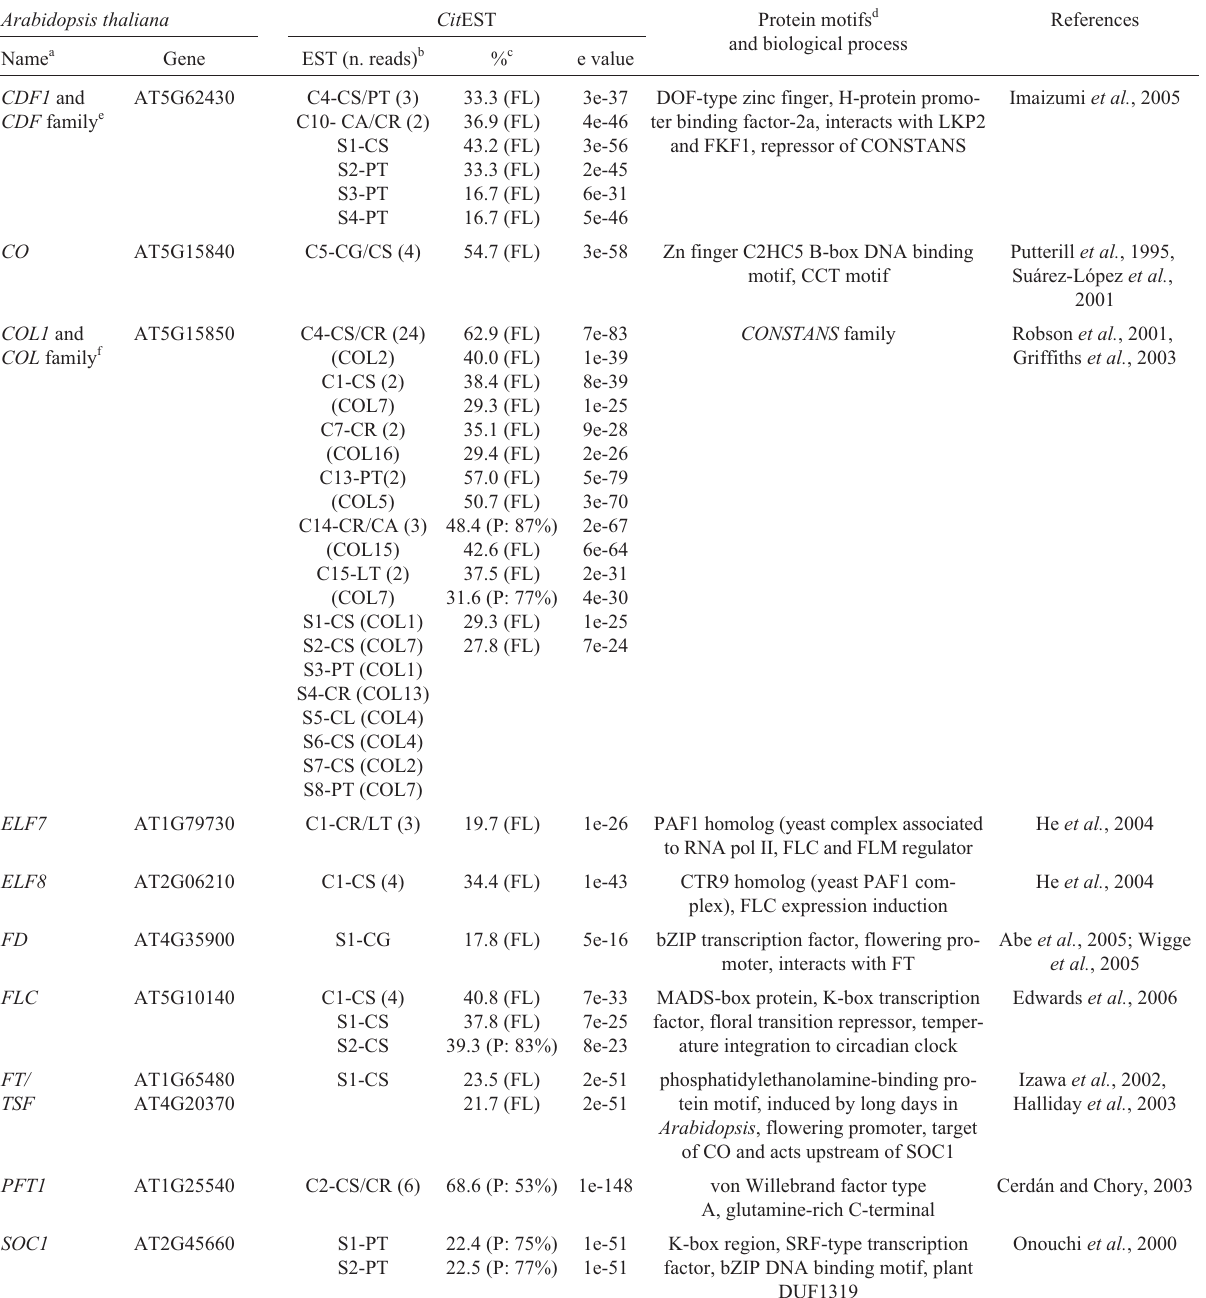
Table 3 - Citrus ESTs with homology to genes involved in the integration of the circadian clock mechanism and the generation of output responses in Arabidopsis thaliana . Arabidopsis thaliana Cit EST Protein motifs d